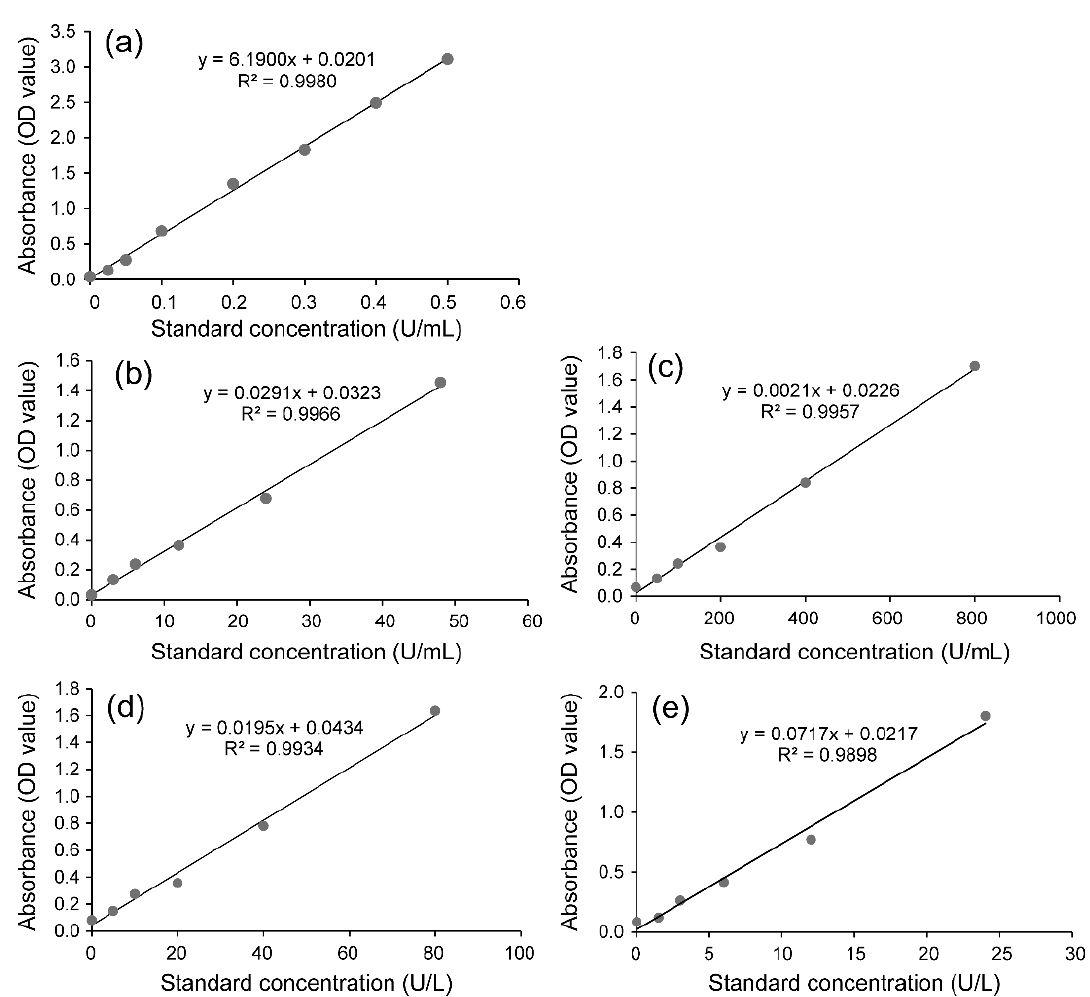
Figure 1. The standard curves of the content of protein ( a ), UDP ‐ glucuronosyltransferases (UGTs) ( b ), carboxylesterases (CarEs) ( c ), glutathione ‐ S ‐ transferases (GSTs) ( d ) and cytochrome P450 monooxygenases (P450s) ( e ).